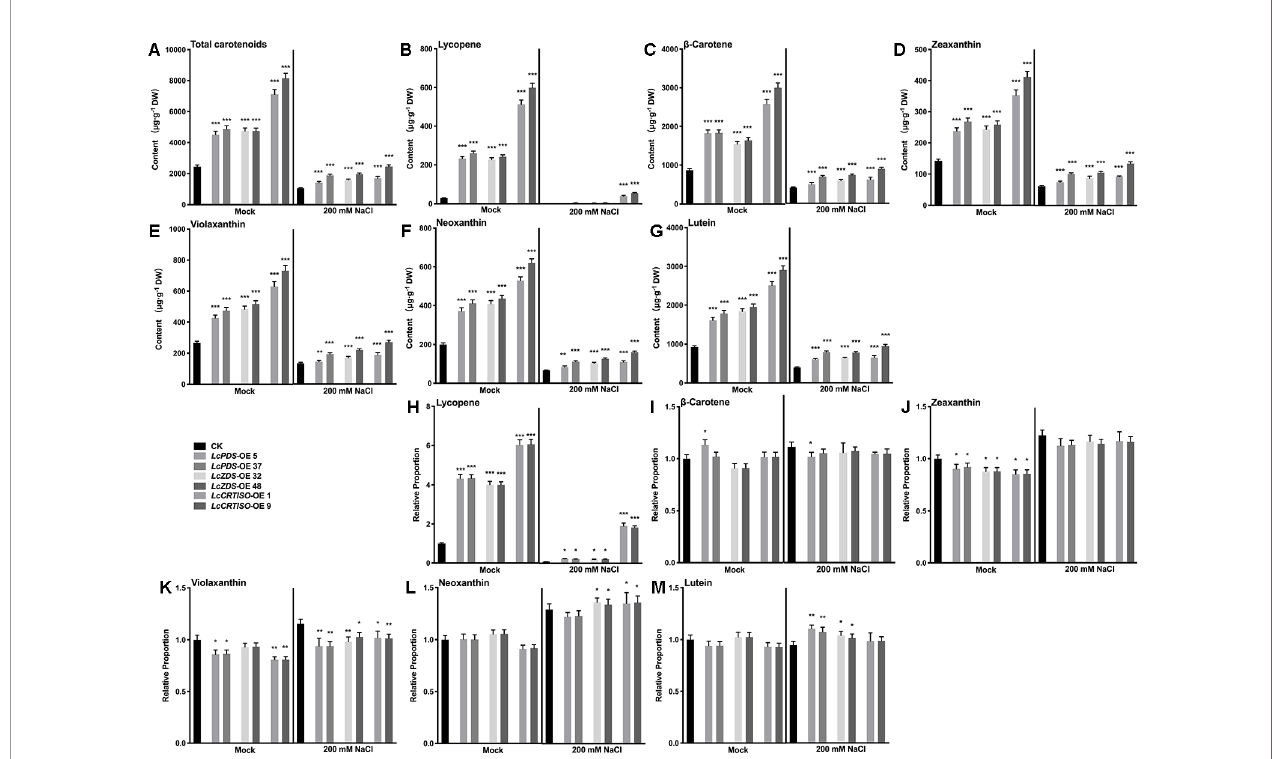
FIGURE 5 | Analysis of carotenoids in LcPDS , LcZDS , and LcCRTISO over-expressing tobacco lines under salt stress. Content of (A) total carotenoids, (B) lycopene, (C) b -carotene, (D) zeaxanthin, (E) violaxanthin, (F) neoxanthin, and (G) lutein. Relative proportion of (H) lycopene, (I) b -carotene, (J) zeaxanthin, (K) violaxanthin, (L) neoxanthin (M) lutein were analyzed in freeze-dried samples and shown as fi gure. Data were obtained from three independent experiments and ANOVAs was performed. The results were presented as means ± SD. P values of < 0.05 (*), < 0.01 (**), and < 0.001 (***) were considered to be signi fi cant